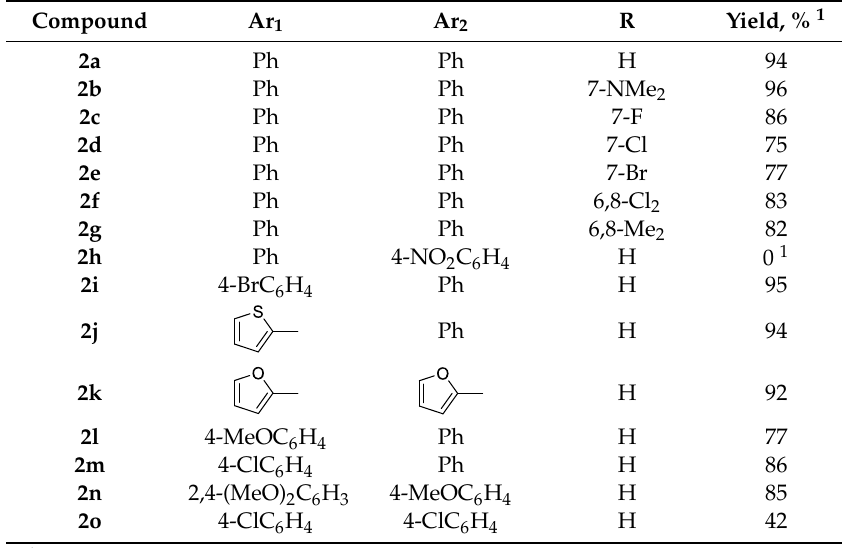
Table 2. Results of the synthesis of 1,3-diaryl-1,2-dihydroacridin-9(10 H )-one derivatives 2 .